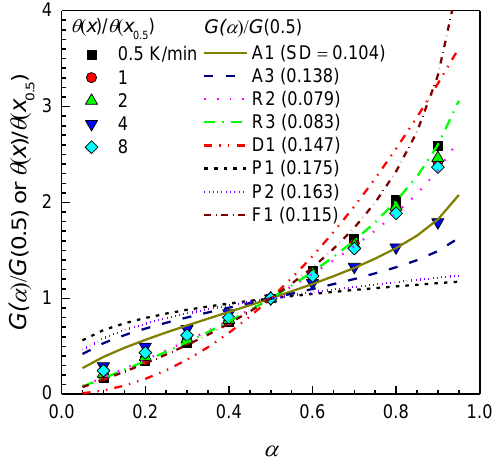
Figure 3. Determination of gasification kinetic model function by comparison of a theoretical master curve to the experimental results.